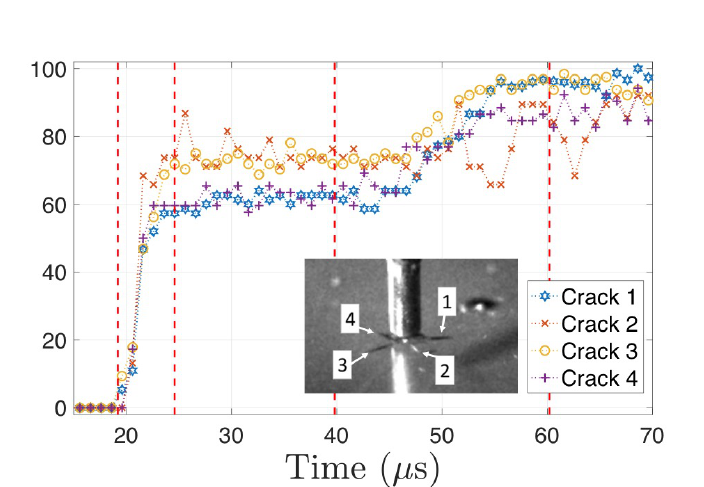
Fig. 3. Crack branches (in % of total length, ∼ 5 mm) evolution versus time. The temporal axis is synchronized regarding the strain gauge measurements with a 0.2 µ s uncertainty.